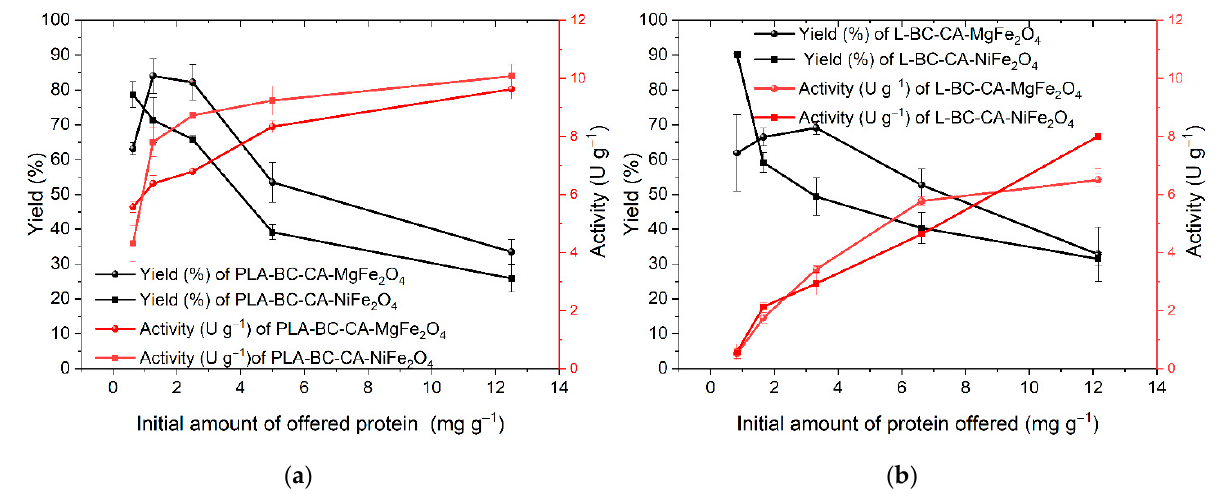
Figure 6. The immobilization yield (%) and activity (units per g of dry carrier mass) of immobilized PLA ( a ) and lipase ( b ) on bacterial cellulose–citric acid-based magnetic carriers.